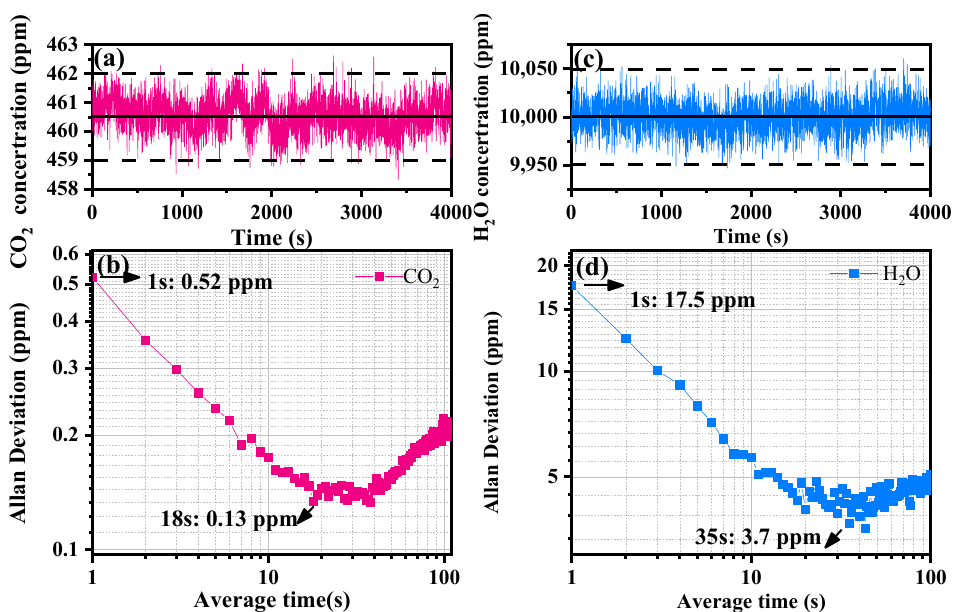
Figure 6. ( a , c ) Standard CO 2 and H 2 O concentrations at 460.5 ppm and 10,000 ppm, respectively, tested for 4000 s; ( b , d ) Allan deviation analyses of CO 2 and H 2 O, respectively, with detection limits as a function of averaging time.